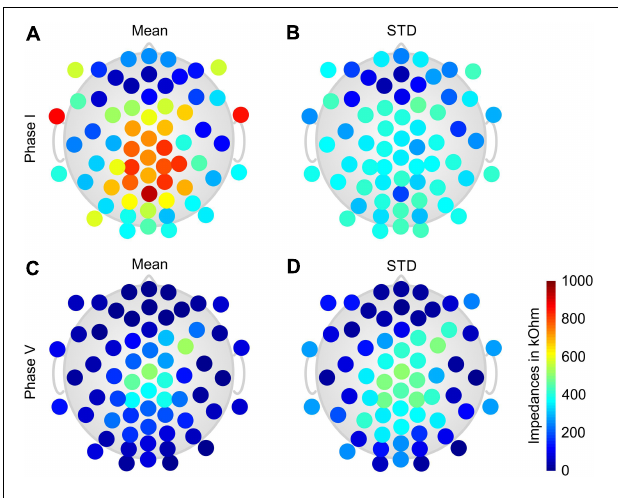
FIGURE 2 | Color-coded topographic plots of the grand average electrode-skin impedances of the dry electrode cap calculated over all volunteers: (A) mean and (B) STD of the impedances at the beginning of Phase I; (C) mean and (D) STD of the impedances at the end of Phase V. Orientation of the topographic plot: nose on